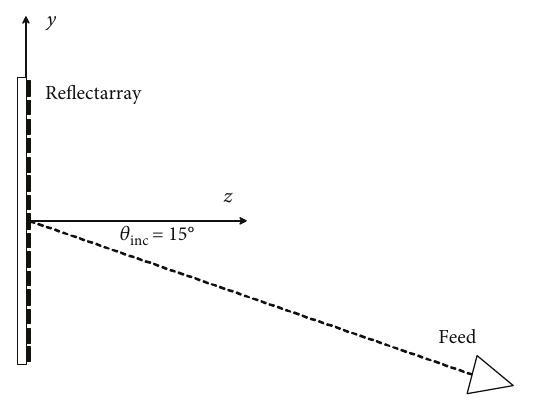
Figure 10: Schematic layout of the 15 × 15 re fl ectarray.